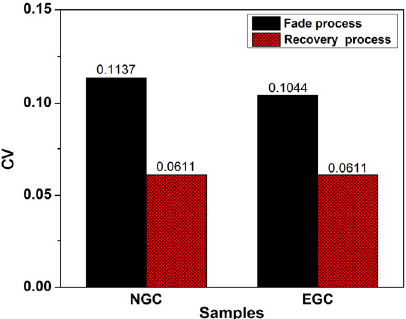
Fig. 6 Stability of the coefficient of friction: